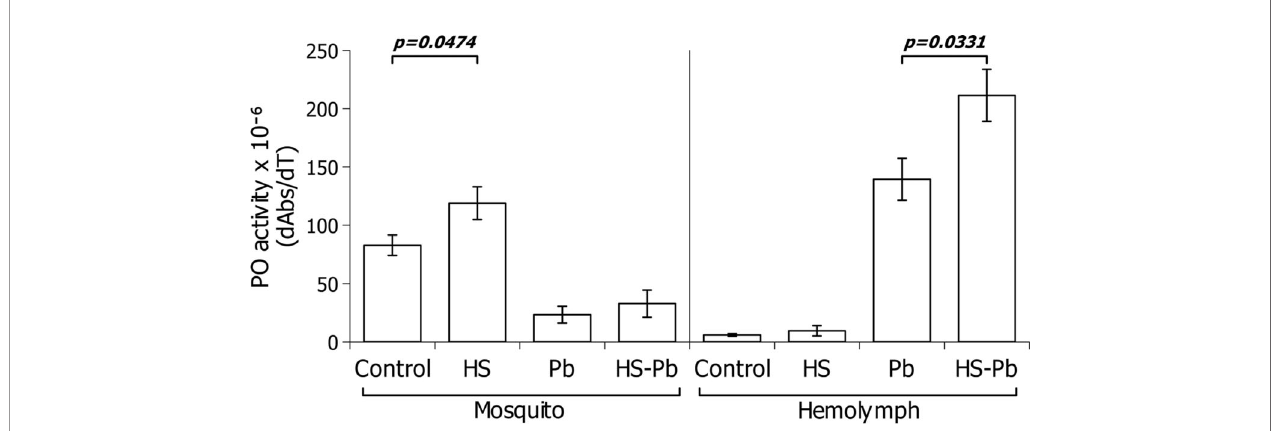
FIGURE 2 | Effect of heat shock on the phenoloxidase response of female A . albimanus during a P. berghei infection. Phenoloxidase activity in macerated body extracts (right) and hemolymph (left). Control, Mosquitoes without heat shock; HS, heat shock mosquitoes; Pb, Plasmodium berghei fed mosquitoes. Data of three independent experiments were analyzed using Student ’ s t-test and are represented with their standard